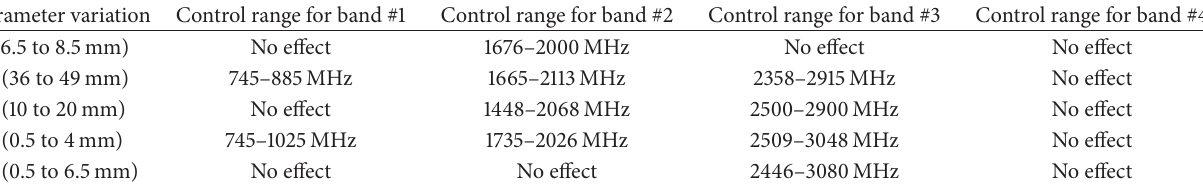
Table 2: Independent control ranges in the four operating bands.